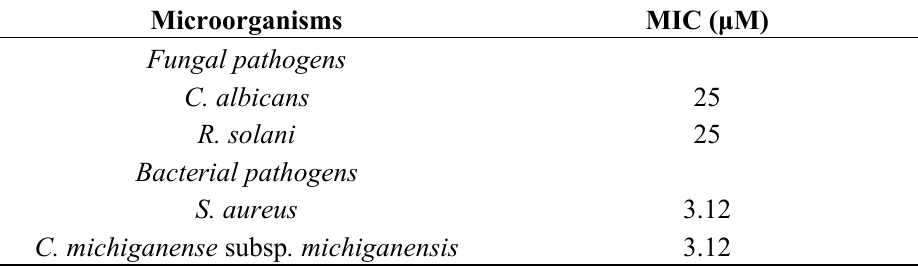
Table 2. Minimal inhibitory concentrations (MICs) for PG-2 against bacterial and fungal strains.